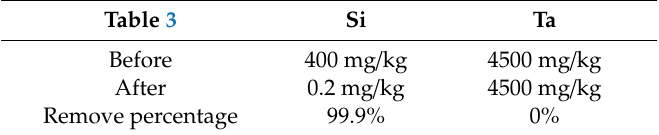
Figure 2. TG/DTG patterns of the EcSETCs with N 2. Table 3. Removed percentage of silicon in the sample after pyrolysis, grinding, and washing.